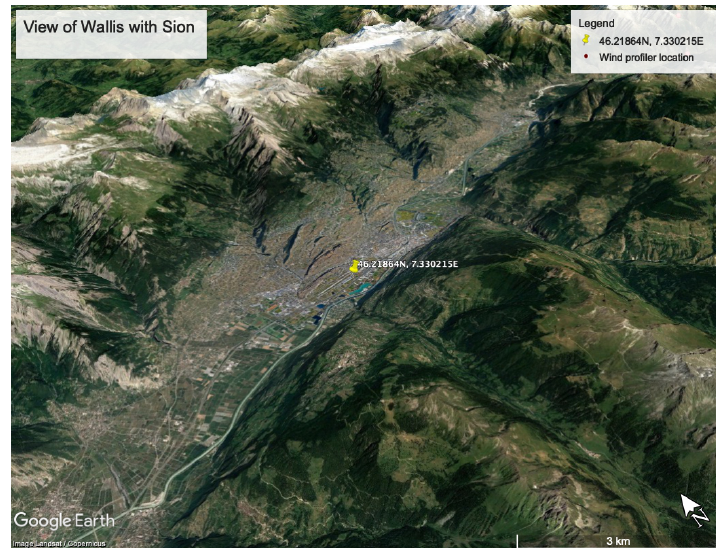
Figure 1. The topography of the Rhone valley around Sion airport and the location of the radar wind profiler (Google Earth